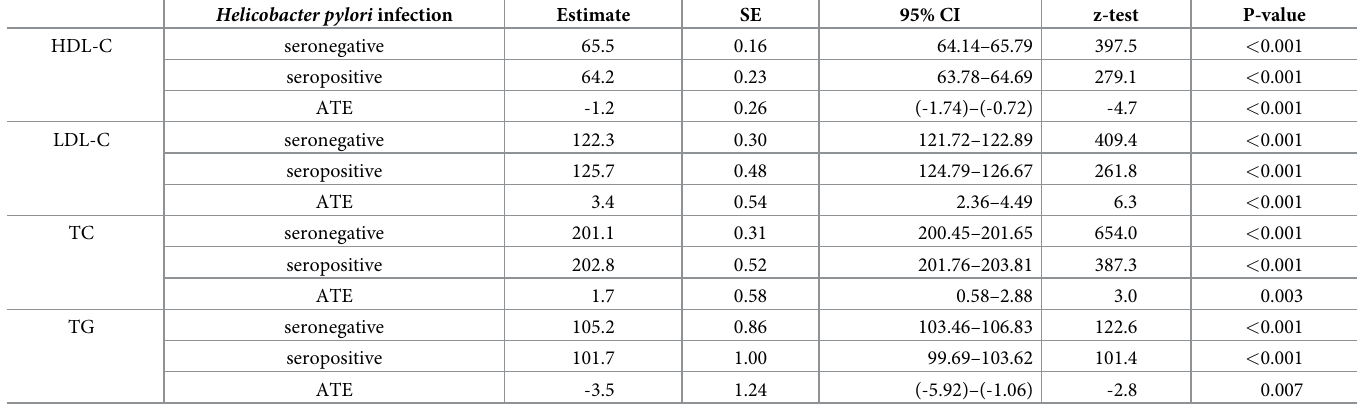
Table 2. Summary of augmented inverse probability weighting reflecting the effect of Helicobacter pylori infection on the serum lipid profile in generally healthy individuals. Helicobacter pylori